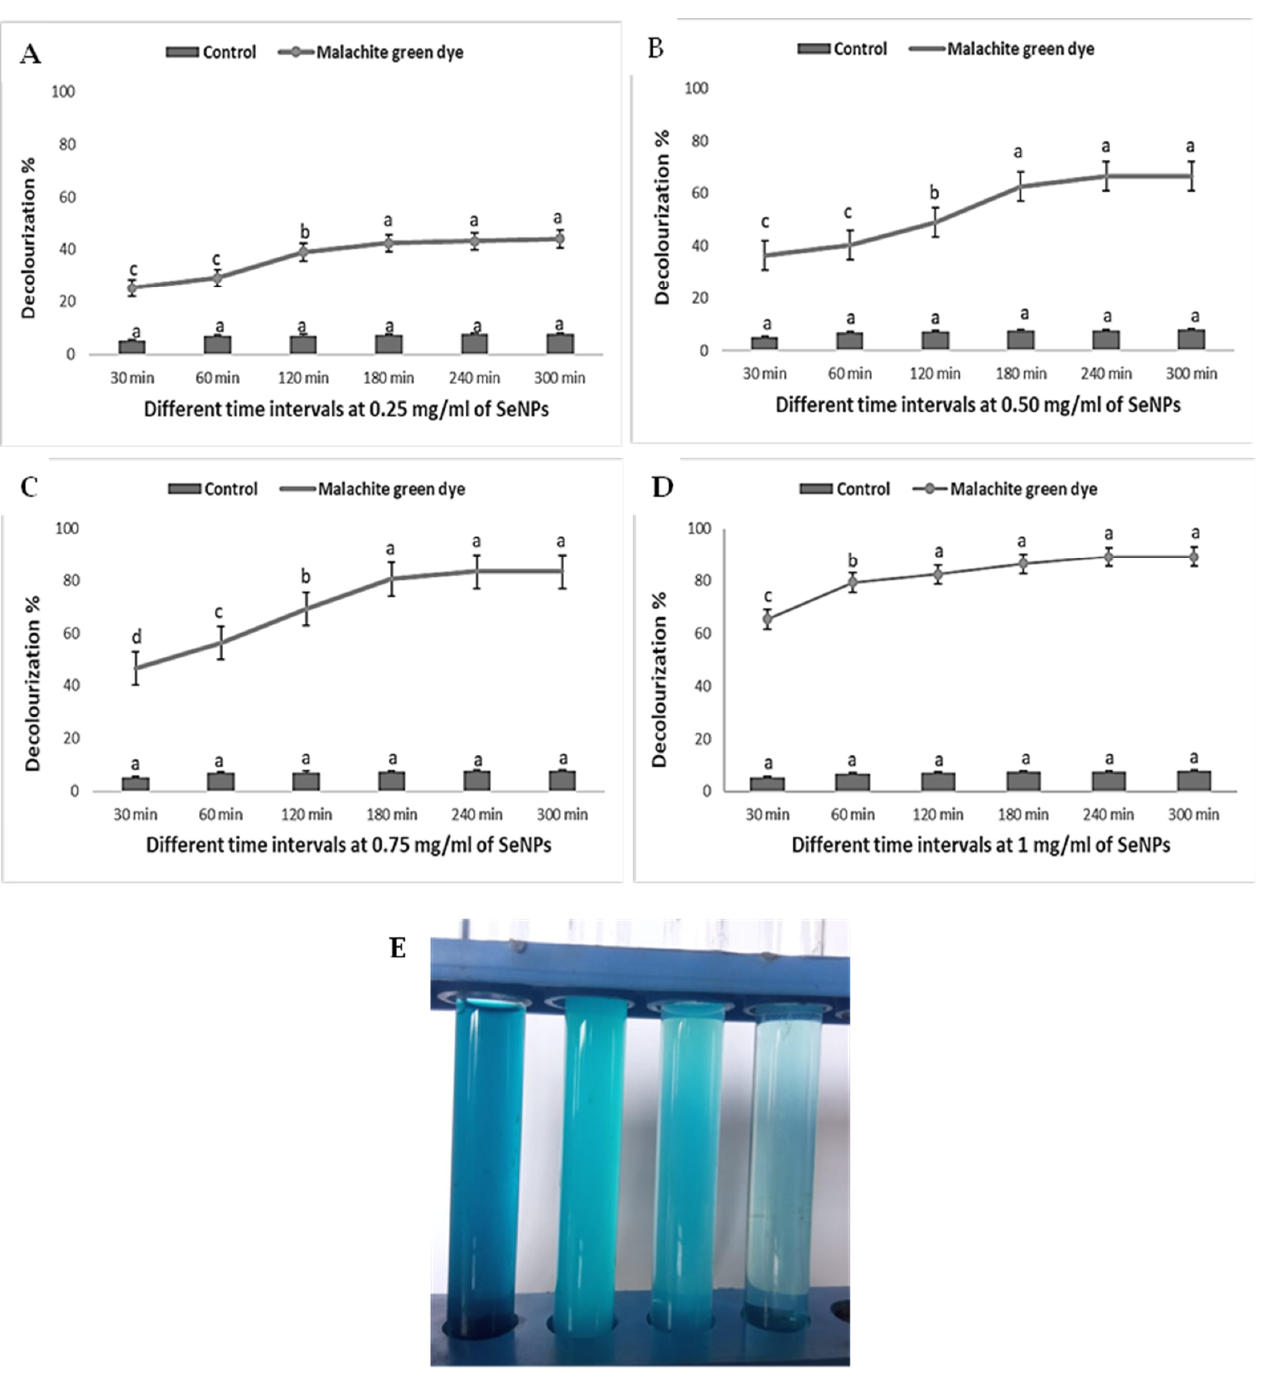
Figure 8. Decolorization percentages (%) of malachite green dye at different concentrations of SeNPs 0.24 ( A ), 0.5 ( B ), 0.75 ( C ), and 1 mg/mL ( D ); and the change of color removal of MG dye at different times ( E ). Letters a, b, c, d Mean significance power